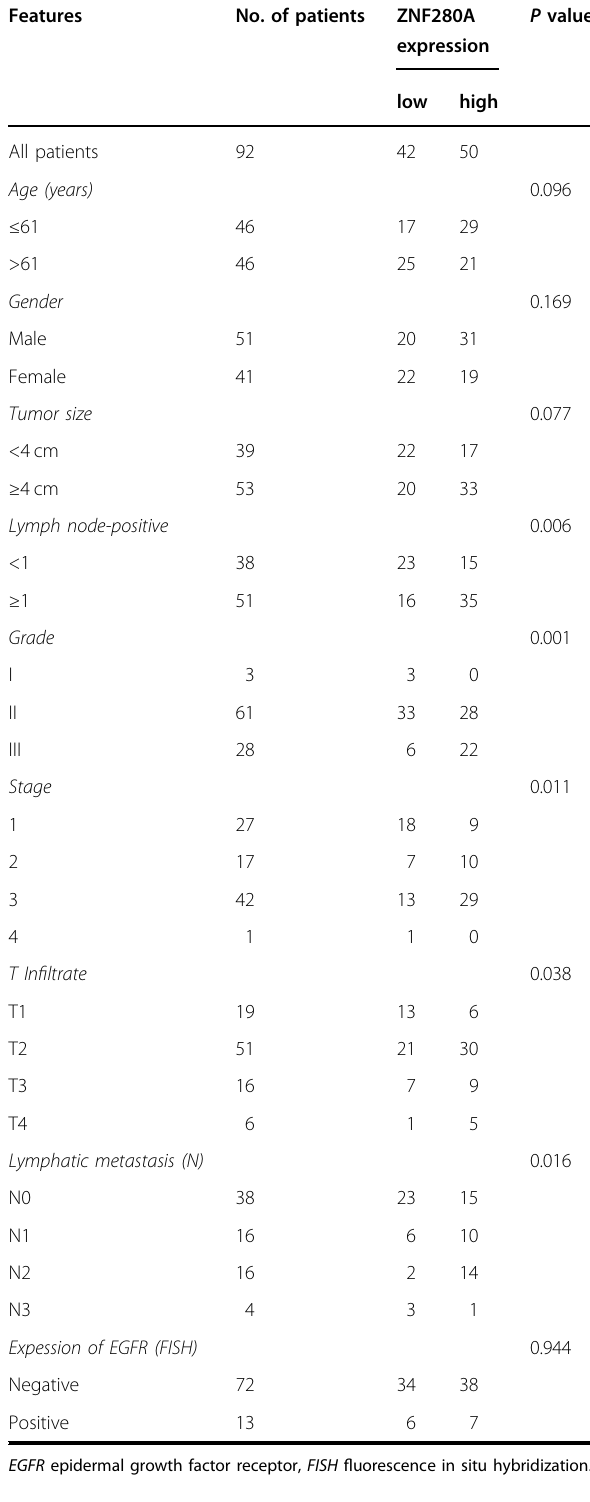
Table 2 Relationship between ZNF280A expression and tumor characteristics in patients with lung